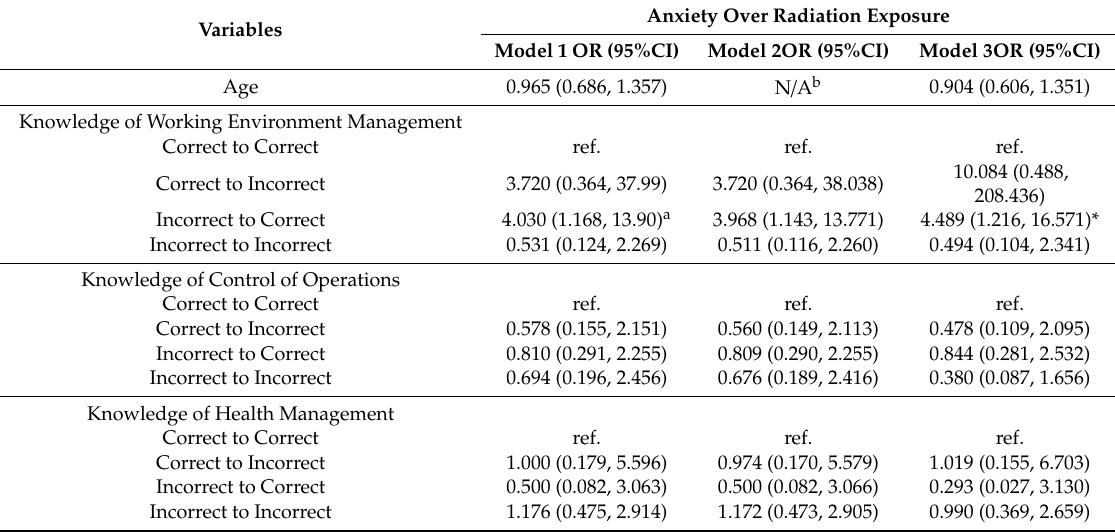
Table 4. Logistic regression model of associations of anxiety over radiation exposure after training session with age and answer